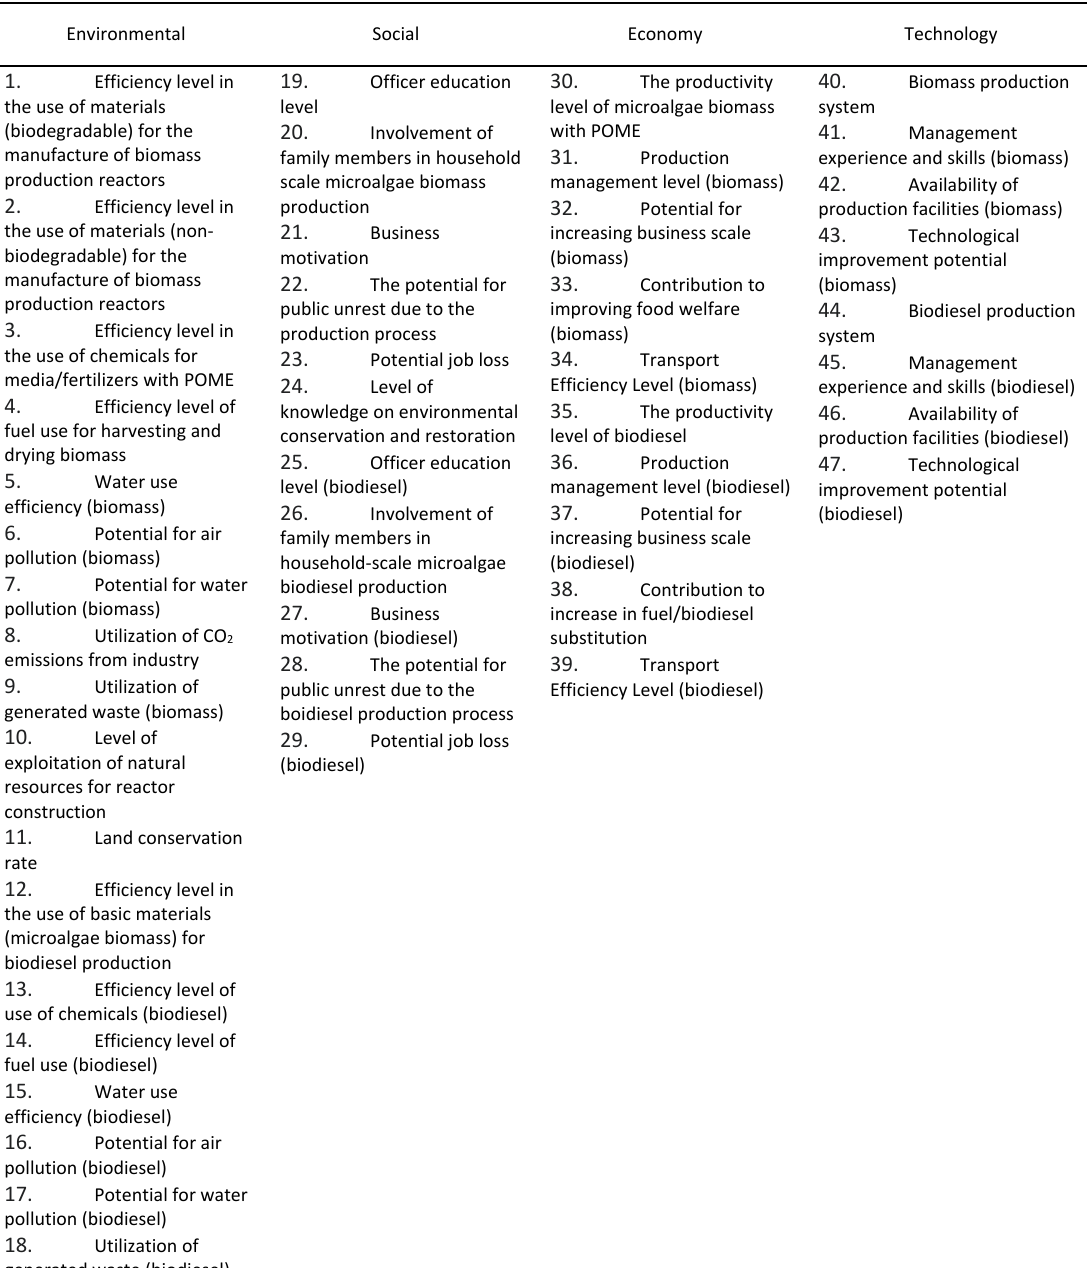
Table 3: List of dimensions and their attributes